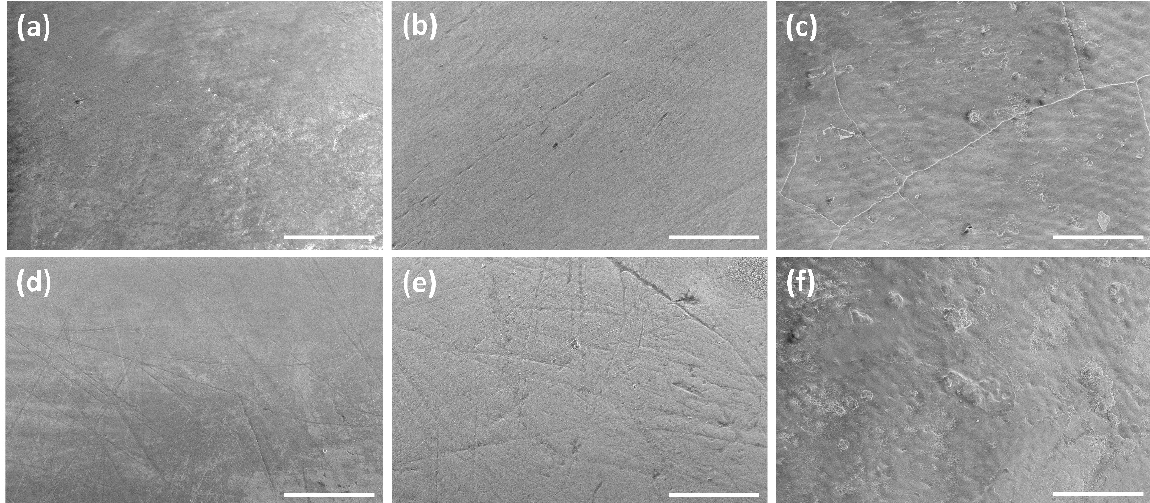
Figure 4. Representative SEM images of tooth enamel surfaces at a magnification of 2000× ( a ) without treatment (as-received), ( b ) after immersion in 250 ppm fluoride in water (pH 5.85), ( c ) after immersion in 250 ppm fluoride in citrate buffer (pH 4.6), ( d ) after immersion in 18,998 ppm fluoride in water (pH 7.76), ( e ) after immersion in 18,998 ppm fluoride in citrate buffer (pH 4.7), and ( f ) after immersion in in fluoride-free citrate buffer (pH 4.6). There was no significant change in the surface topography after immersion if the high variation between the teeth was taken into account. Scale bars 50 µm.